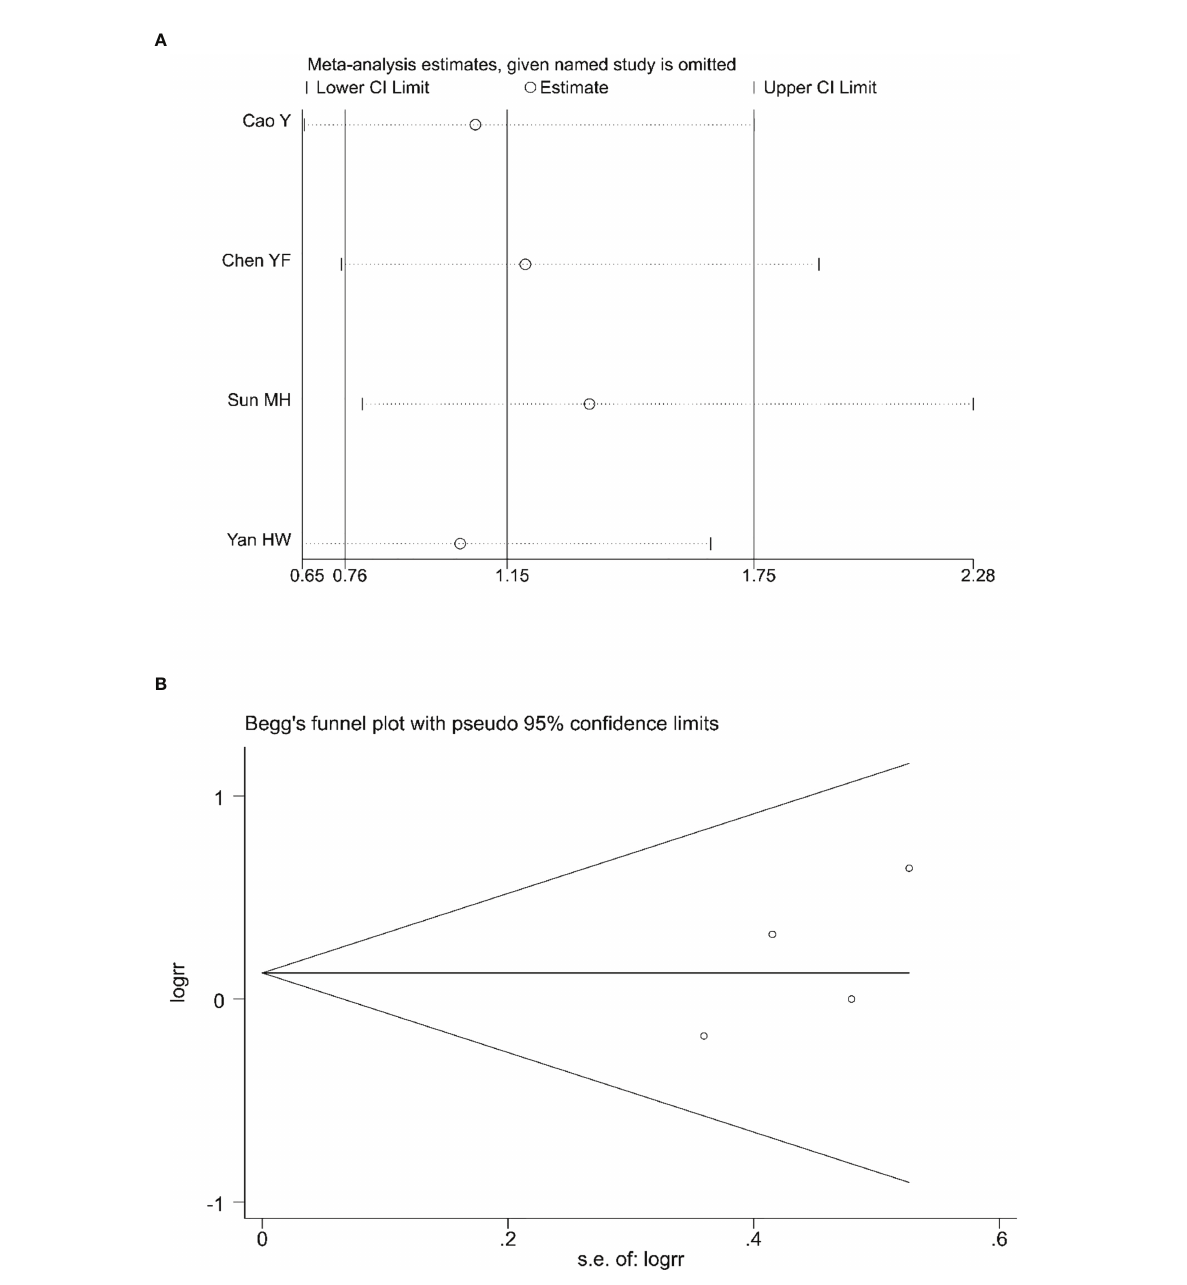
FIGURE 8 Sensitivity analysis (A) and Begg ’ s funnel plot (B) for the analysis of PRR. (Begg ’ s test: p = 0.308). PRR, partial remission